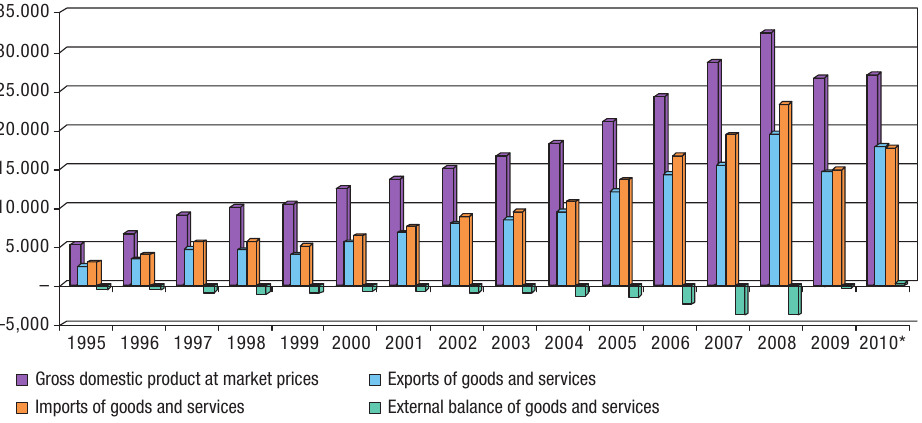
Fig. 1. Lithuanian GDP and international trade volumes during 1995–2010, mill. EUR Source : data from EUROSTAT (2010* – EUROSTAT